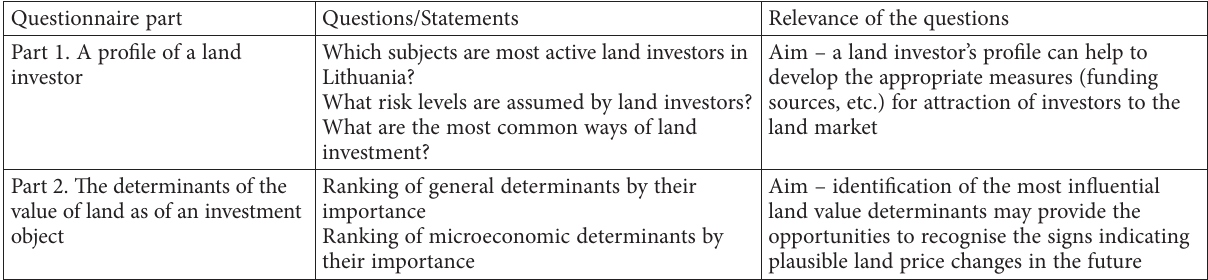
Table 2. Relevance of the